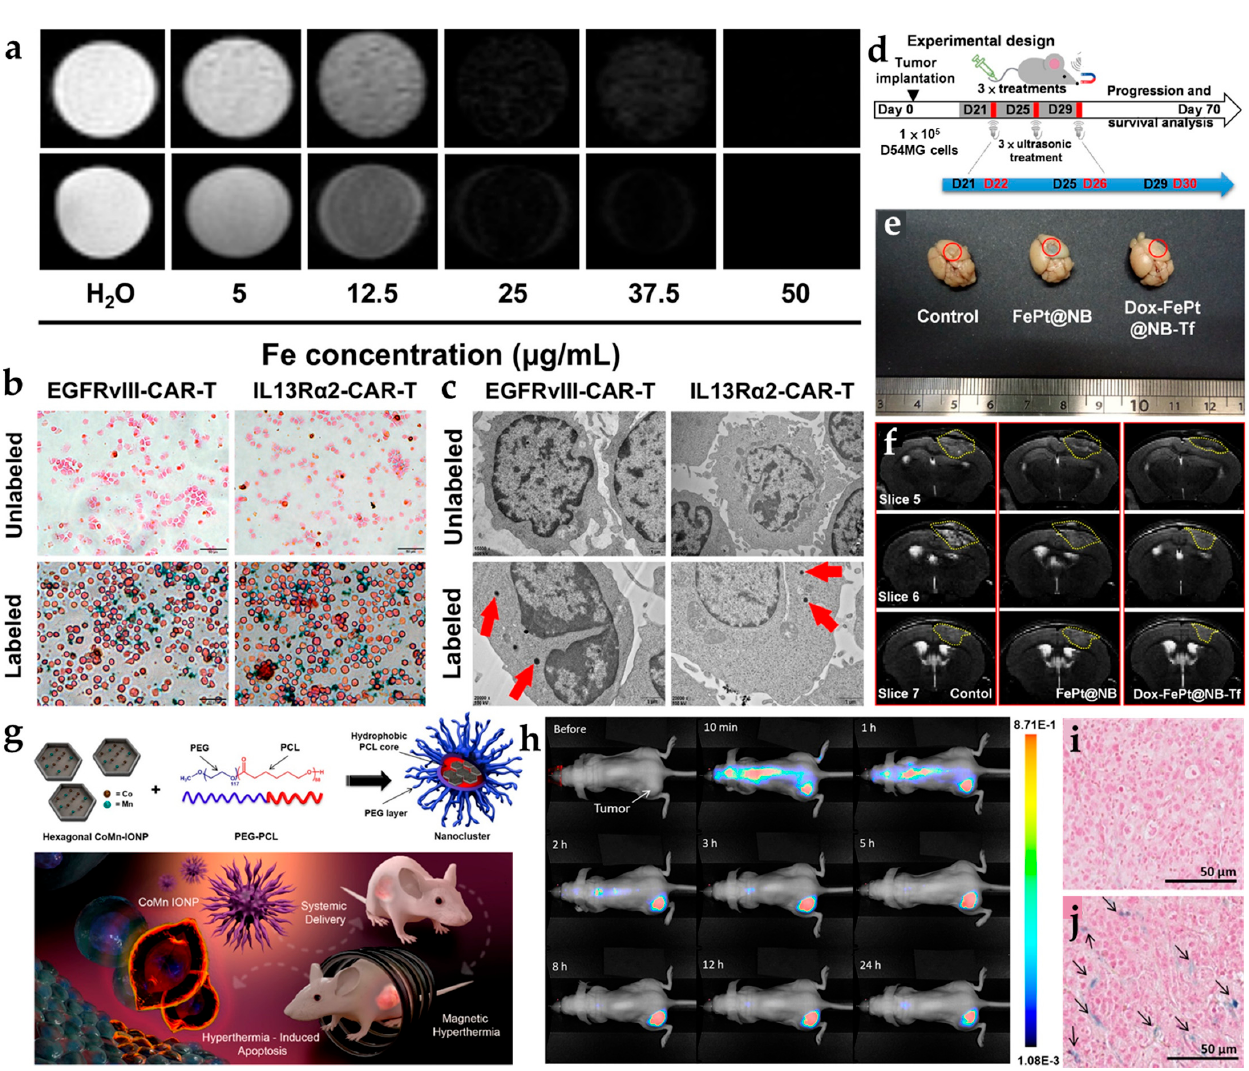
Figure 3. The various types of iron-based nanoplatforms in glioblastoma theranostics. ( a ) T2-weighted images containing iron-oxide nanoparticles labeled CAR-T cells, EGFRvIII CAR-T (upper row), and IL13R α 2 CAR-T (lower row) cells. ( b ) There are representative images of Prussian-blue-stained, unlabeled CAR-T cells (top) and labeled CAR-T cells (bottom). ( c ) Cell TEM views of unlabeled CAR-T cells (top) and labeled CAR-T cells (bottom) [18]. ( d ) Illustrative mice model of synthesis and HIFU-triggered drug release from FePt@NB. ( e ) Photos of mouse brains with GBMs. The GBM tumors are circled with a yellow highlight. ( f ) T2-weighted MRI images of mouse brains with GBMs. The GBM tumors are highlighted in yellow circles [32]. ( g ) Graphical representation of CoMn IONP encapsulated inside PEG/PCL polymers. ( h ) IVIS system analyzed for injection of CoMn-IONP nanoclusters loaded with a hydrophobic NIR dye. Prussian-blue staining of tumor slices of ( i ) 5% dextrose and ( j ) CoMn-IONP nanoclusters [34]. Adapted with permission from Refs. [18,32,34], Copyright 2021 Elsevier, 2019 and 2021 American Chemical